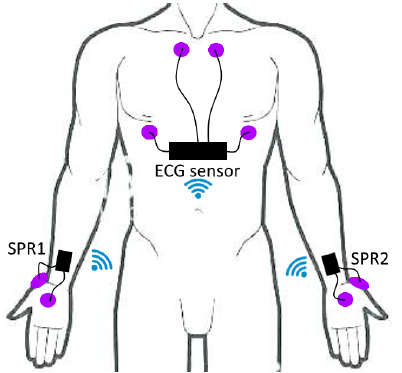
Figure 2. Placement of the ECG and SPR